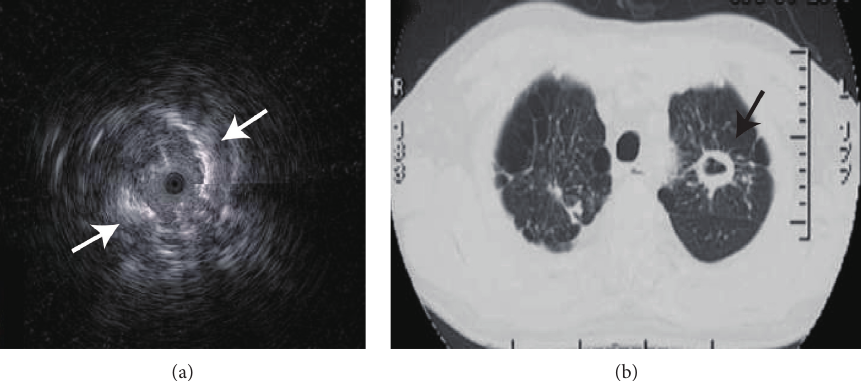
Figure 3: An EBUS image of pulmonary tuberculosis. The image was from a 55-year-old man with a left upper lobe cavity lesion ((b) black arrow). The image contained heterogeneous internal echoes and luminant areas ((a) white arrow).